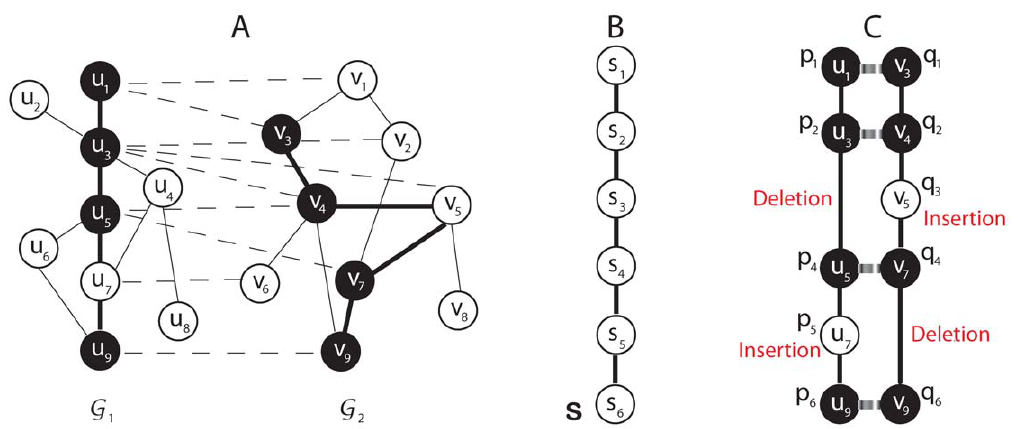
Figure 1. Network representation and alignment. (A) Example of two undirected biological networks G 1 and G 2 . (B) A virtual path s that corresponds to the alignment of best matching paths. (C) The top-scoring alignment between two similar paths p (in G 1 ) and q (in G 2 ).